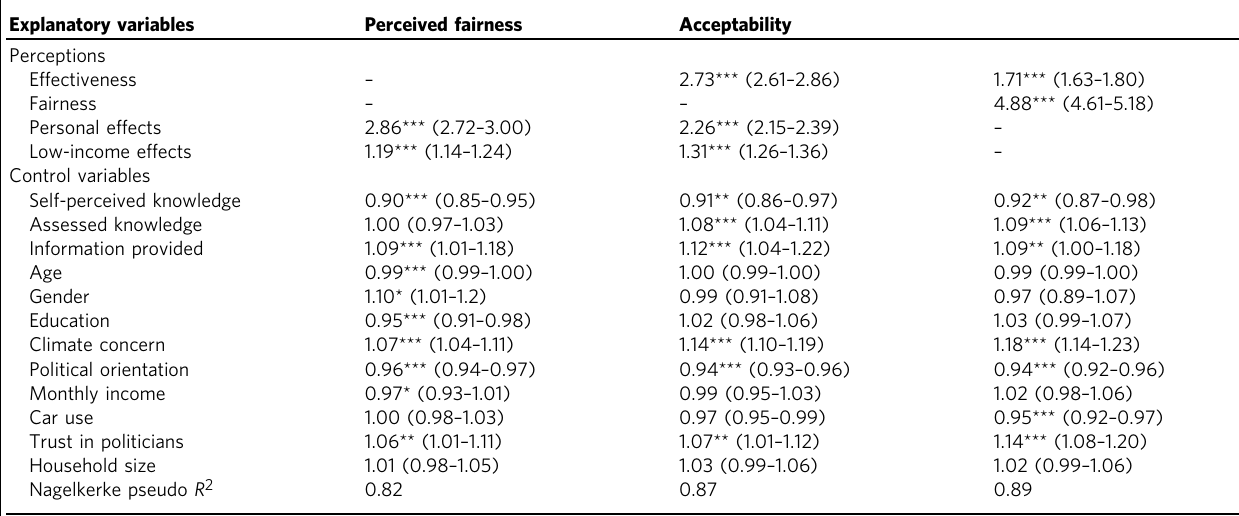
Table 2 Determinants of fairness and acceptability. Explanatory variables Perceived